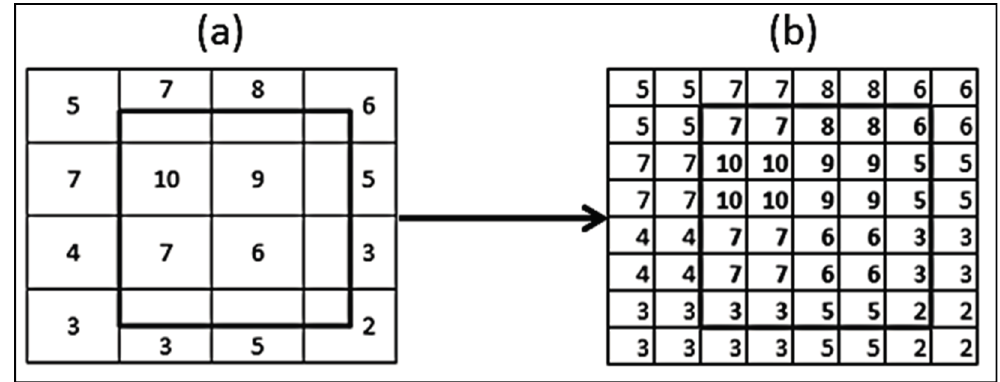
Figure 2. Image segment polygon (bold line) overlaid onto a grid of pixels with intensity values ( a ). The intersected pixels in (a) are the partial sub-objects of the segment, while the pixels located completely within the segment are the true sub-objects of the segment. The pixels from (a) are resampled to ½ of their original spatial resolution (e.g., from 30 m to 15 m resolution) using nearest neighbor resampling, and the intensity values of the resampled pixels are shown in ( b